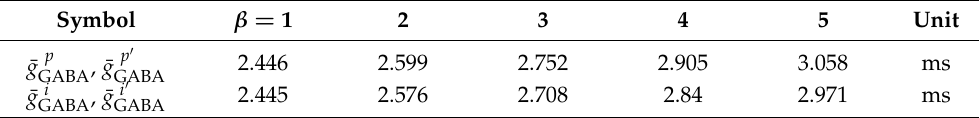
Table 4. Average GABAergic conductance values for the two-cortical-column model where = ¯ g p , i , p (cid:48) , i (cid:48) AMPA